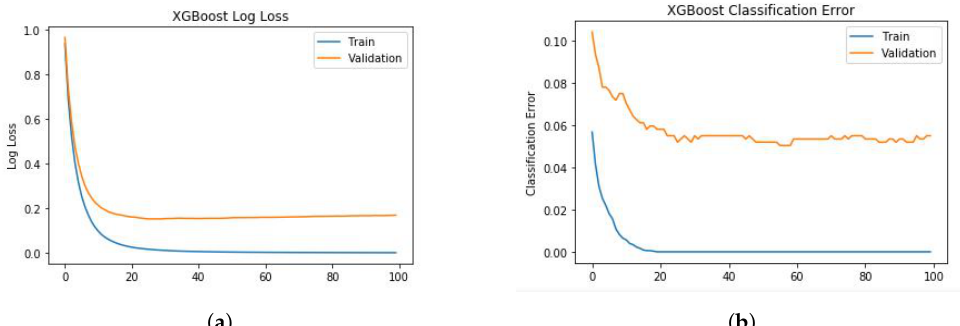
Figure 12. ( a ) Logarithmic loss in Shallow VGG with Xgboost ( b ) Classification error in shallow VGG with